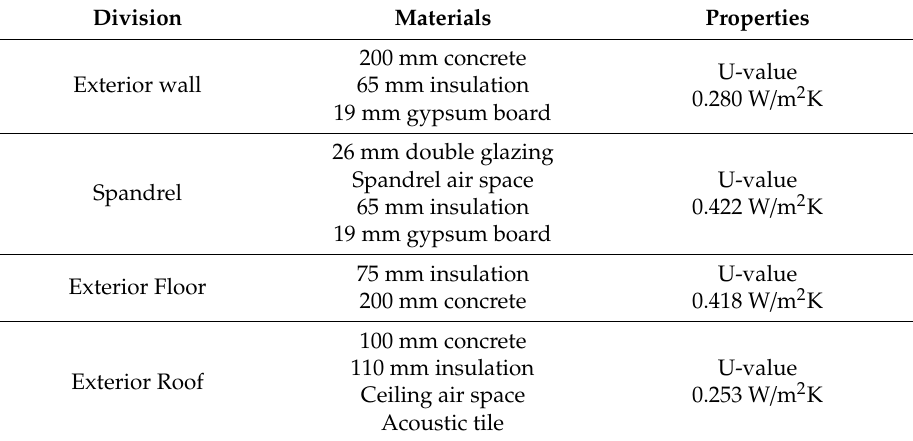
Table 12. Thermal properties of the exterior wall of the analysis